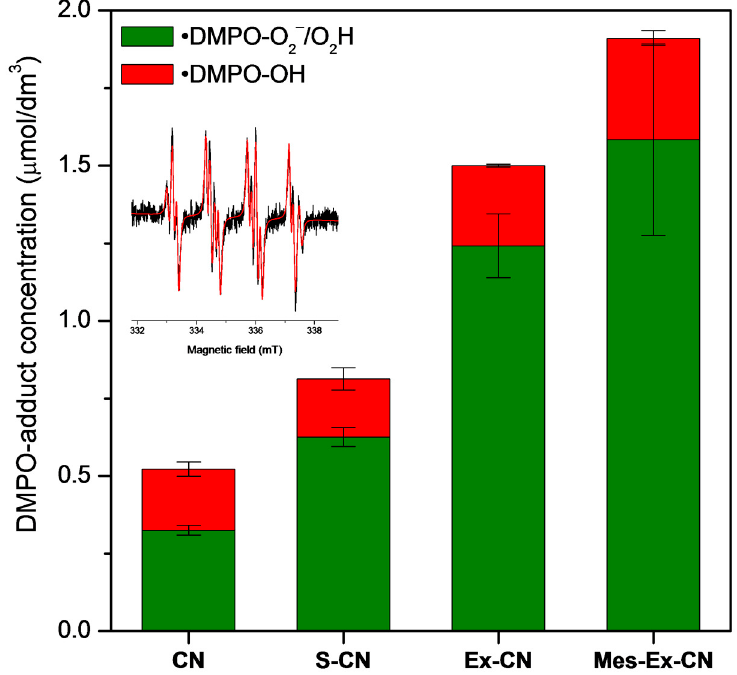
Figure 12. Concentration of · DMPO-O 2 / O 2 H and · DMPO-OH spin-adducts evaluated from the EPR spectra measured upon UV exposure of aerated aqueous suspensions of photocatalysts in the presence of 5,5-dimethyl-1-pyrroline N -oxide (DMPO) spin trap. ( λ max = 365 nm, UVA dose 4.5 J / cm 2 , photocatalyst loading, 0.5 mg / mL; c 0 (DMPO) = 0.04 mol / dm 3 ). Inset: experimental spectrum (black line) obtained upon continuous irradiation of a Mes-Ex-CN suspension under the given experimental conditions along with its simulation (red line).